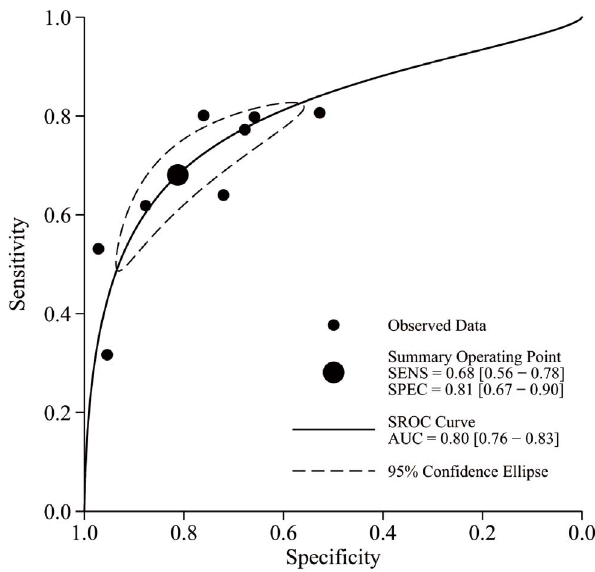
Figure 4. Summary receiver operating characteristic (SROC) plot of eight studies on a TLC threshold of 1500 cells/mm 3 for predicting a CD4 cell count , 350 cells/mm 3 . The area under the SROC curve (the solid line) is 0.80; the larger dot is the pooled value for sensitivity and specificity (0.68 and 0.81, respectively); the ellipse around the larger dot represents the 95% confidence interval around the